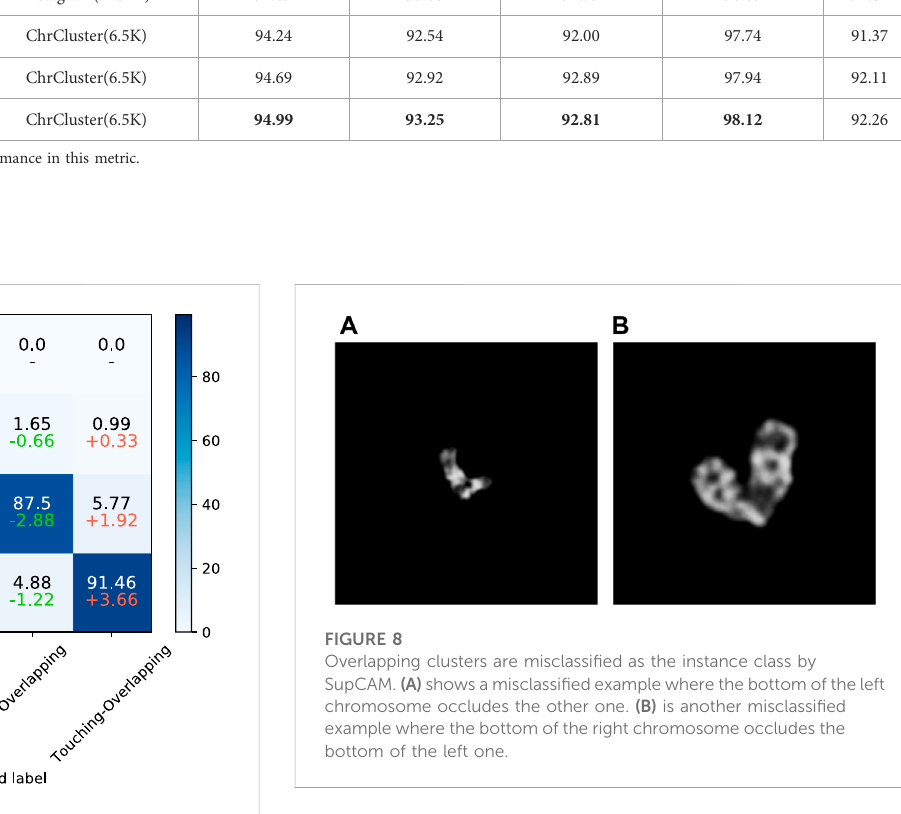
FIGURE 7 The fi rst line of each cell is the confusion matrix of SupCAM with ResNeXt101 backbone on the test set. Besides, on the second line of eachcell,weshowdifferencesbetweenLinetal.(2021)andourmethod, in which red and green represent increment or decrement of percentage, respectively.